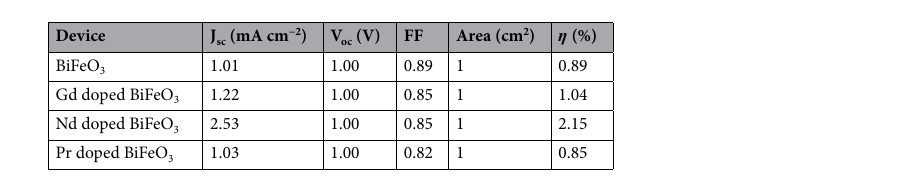
Table 1. Photovoltaic parameters of the DSSC fabricated by using an extracted mint ( Mentha ) dye solution.